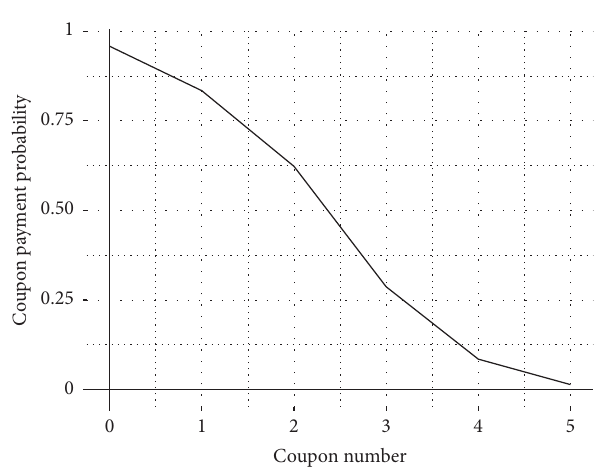
Figure 5: Probability of coupon